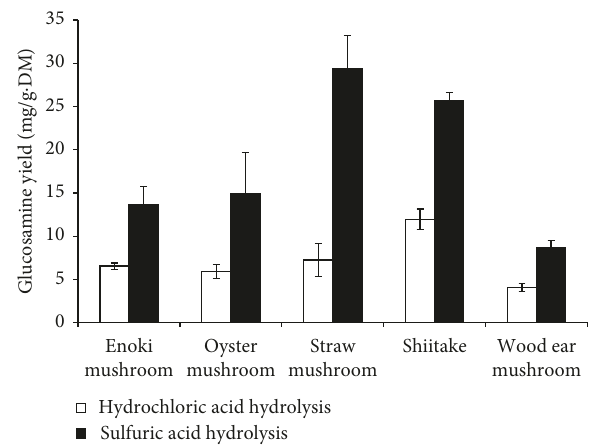
Figure 1: Effects of hydrochloric and sulfuric acids on glucos- amine yield. Hydrolysis conditions: ratio of raw material to acid volume (1 :10, w/v), 6 M acid, 80 ° C, and 8